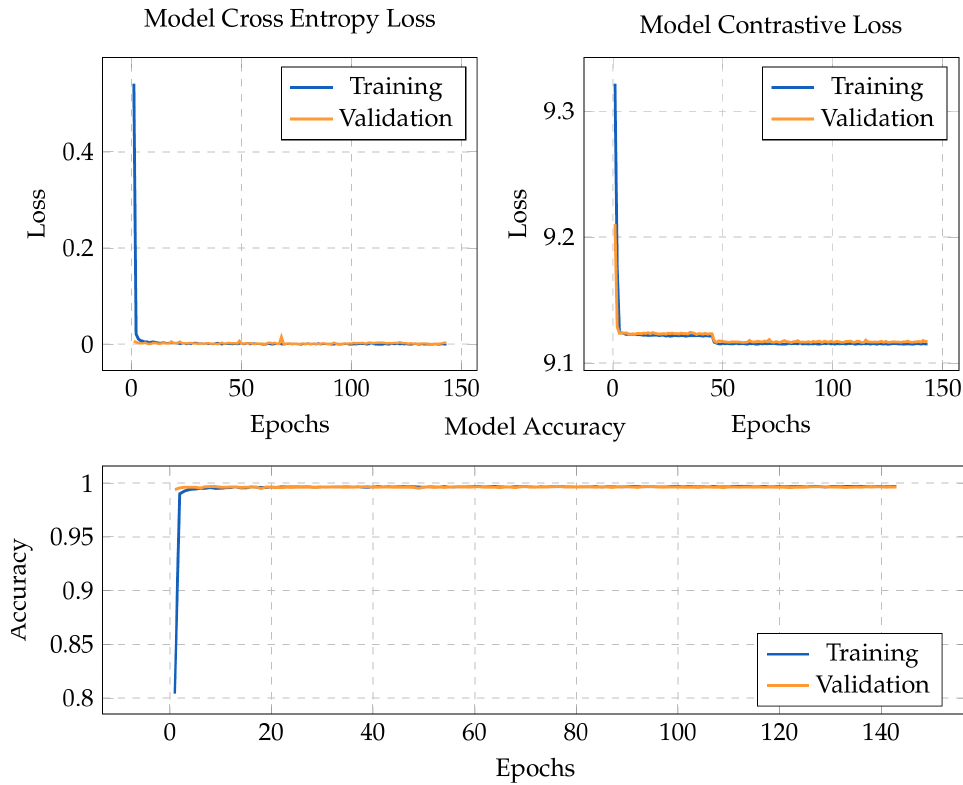
Figure 9. Training curves implementing the simultaneous multi-loss method. The graphs present the model’s accuracy and losses in the training and validation dataset in each epoch.